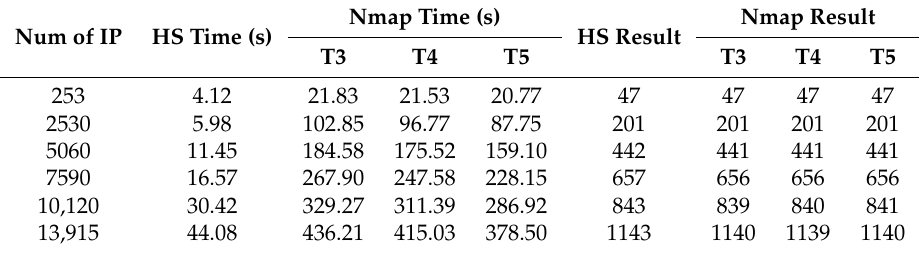
Table 2. Scanning results of HIRFL Scanner and Nmap IP Scanner.